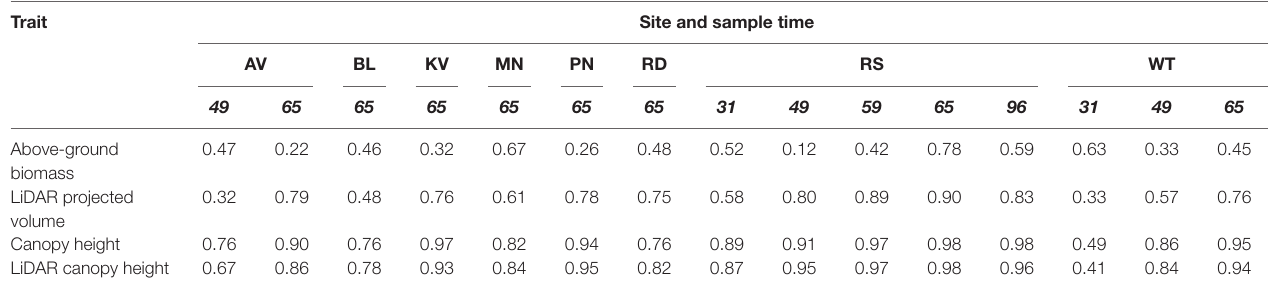
TABLE 5 | Broad-sense heritability of each trait, at each site and sample time (ZGS), measured in the current study. Trait Site and sample time